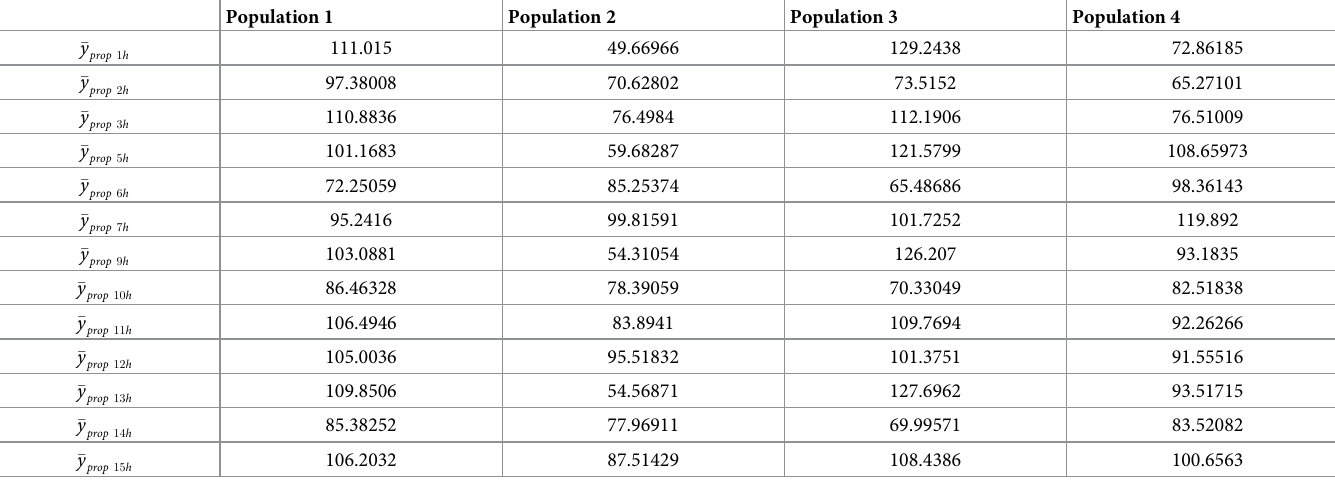
Table 10. Percentage relative efficiency of proposed family